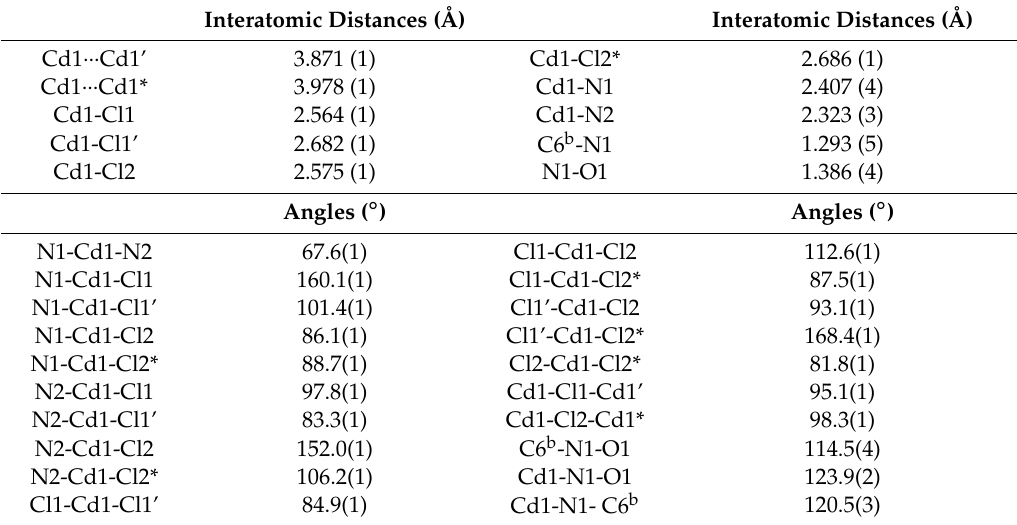
Table 3. Selected interatomic distances (Å) and angles ( ◦ ) for complex {[CdCl 2 (phpaoH)]} n ( 2 ) a .